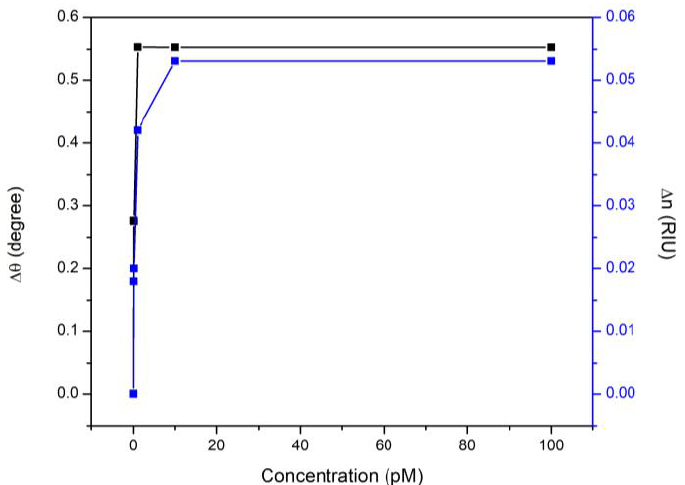
Figure 5. The increased change in the real part of the refractive index and resonance angle shift after the interaction of CQD film with different levels of DA.